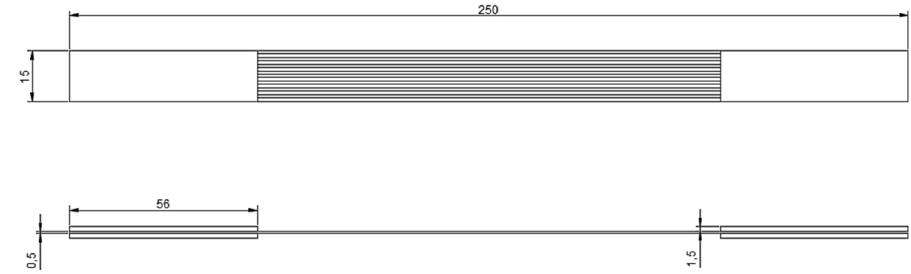
Figure 4: Specimen